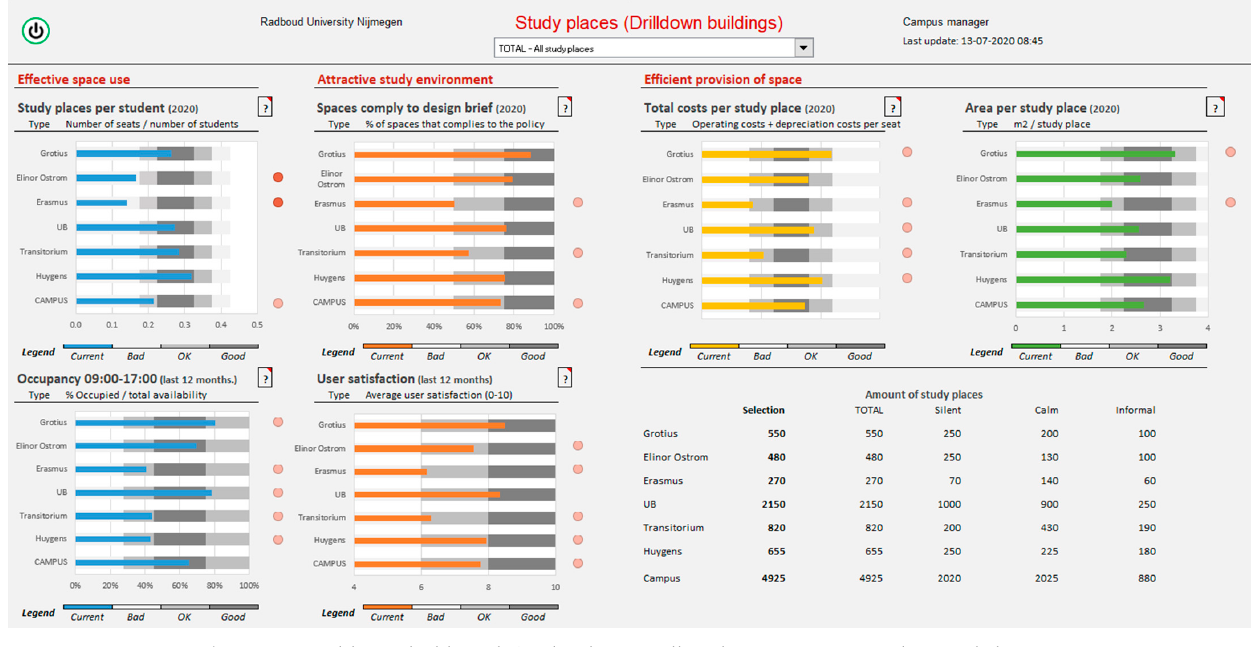
Figure A1. Buildings dashboard ‘Study places Radboud University’ (tested in workshop 2).